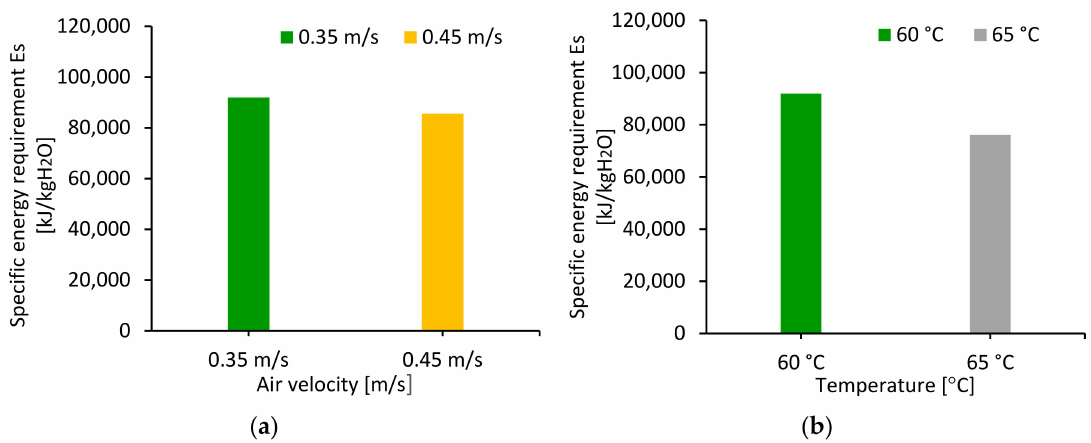
Figure 16. Specific energy requirements for 25 kg / m 2 bulk dried at ( a ) 0.35 m / s and 0.45 m / s at 60 ◦ C ( b ) 60 ◦ C and 65 ◦ C at 0.35 m /